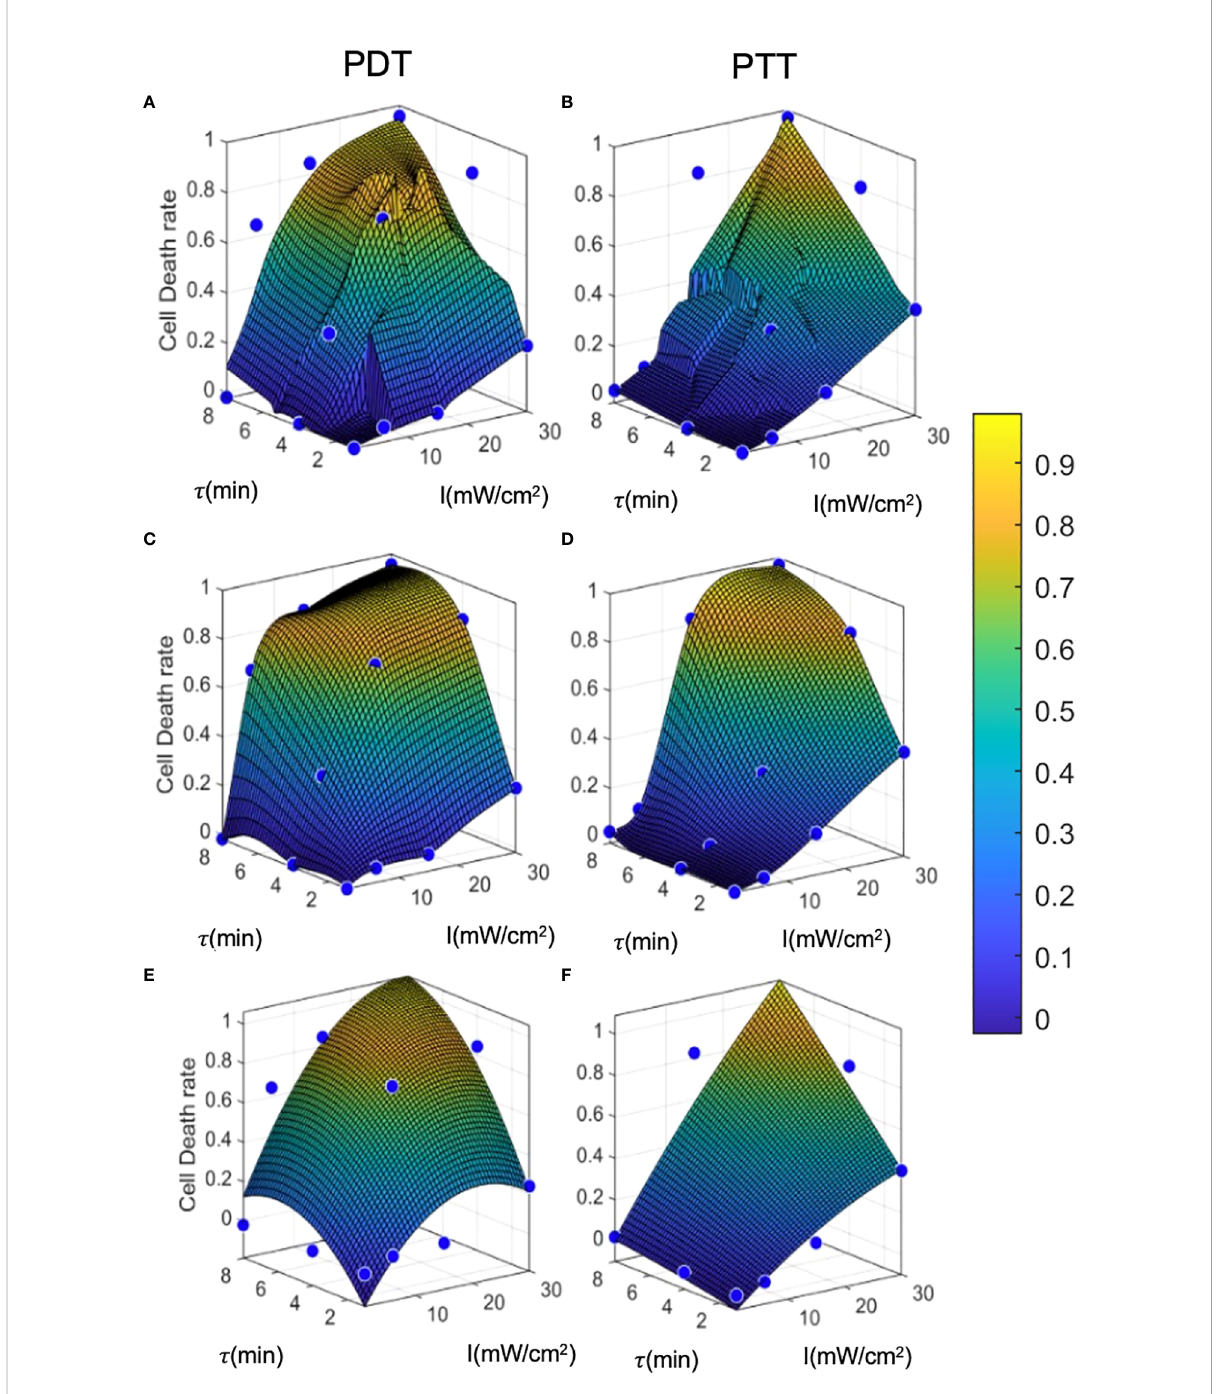
FIGURE 6 Prediction model curves. (A-F) illustrate the curves generated by prediction models based on regression, interpolation, and analytical function fi tting for PDT and PTT, respectively. Blue points represent the mean values of training